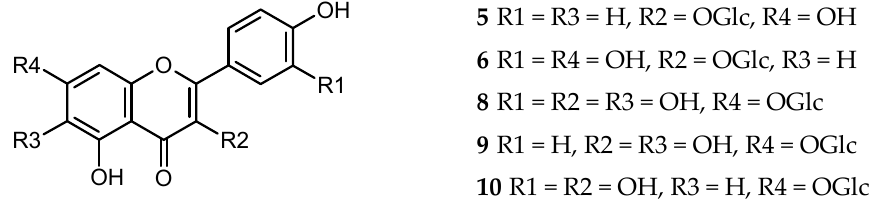
Figure 2. Chemical structures of flavonoids ( 5 , 6 , 8 – 10 ) isolated from capitula of X. speciosissima